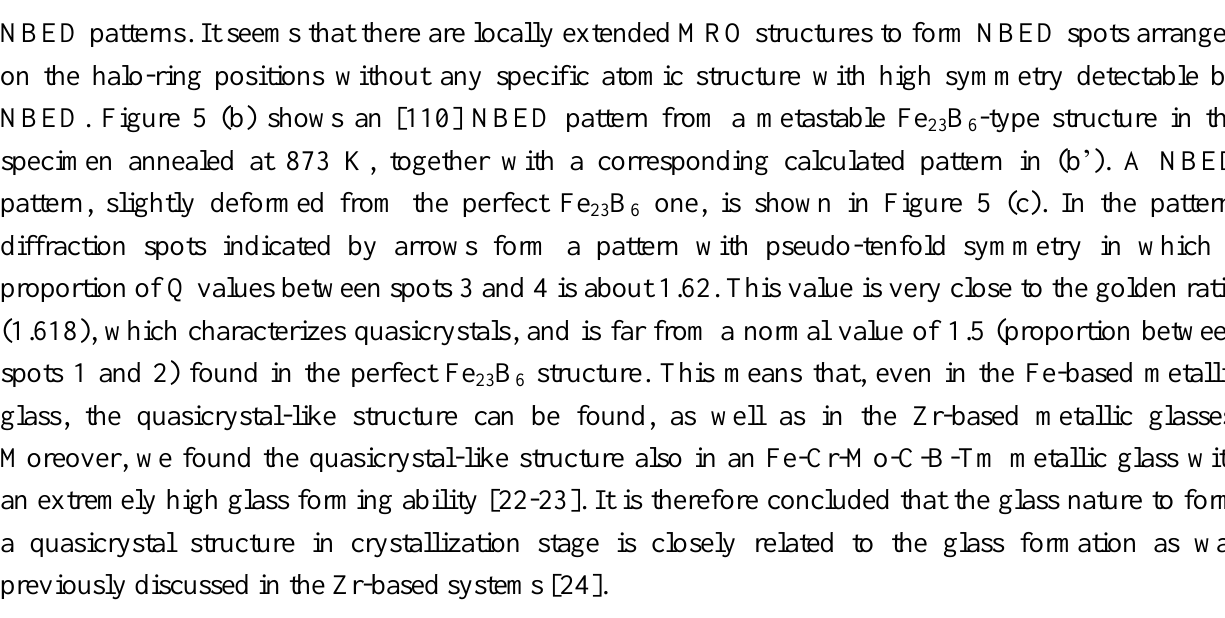
Figure 4. Change of reduced interference functions obtained from Fe heating. The glass state directly transforms into a metastable Fe